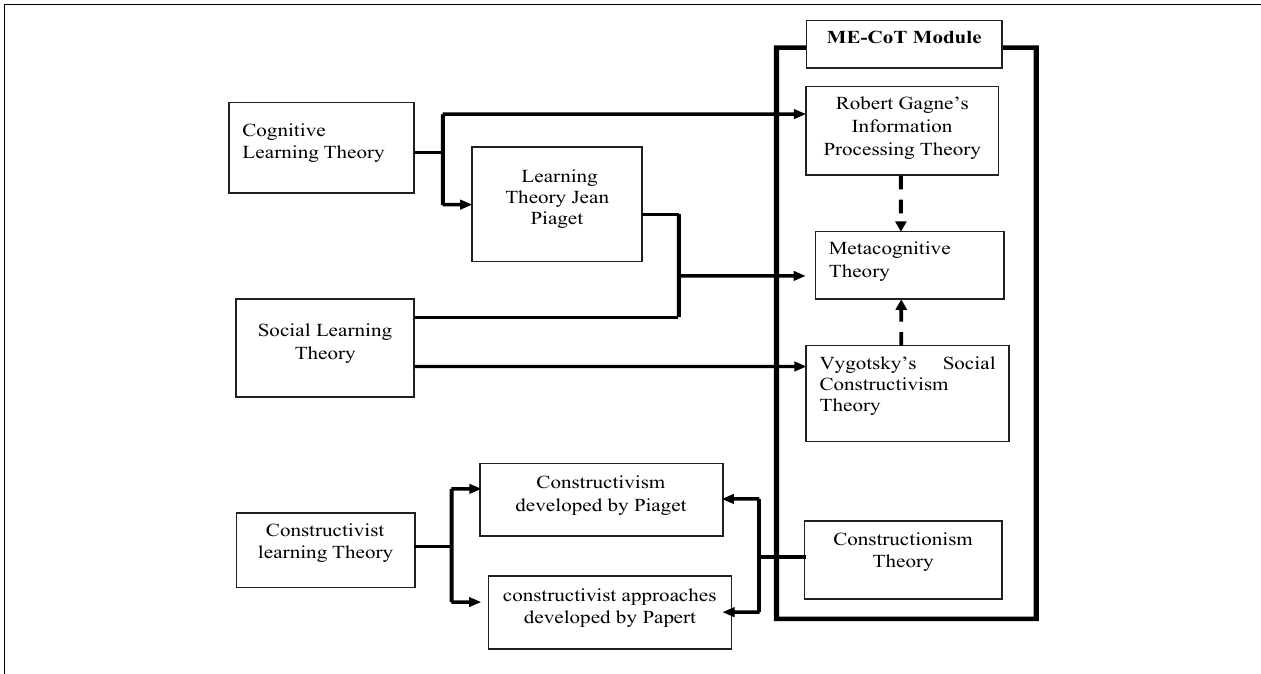
FIGURE 2 | Theoretical